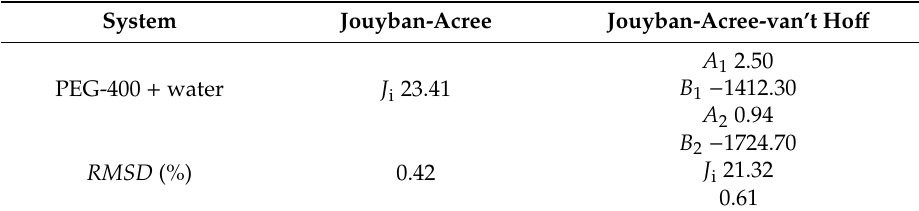
Table 8. The parameters of the “Jouyban-Acree” and the “Jouyban-Acree-van’t Ho ff ” models for ECT in “PEG-400 + water”